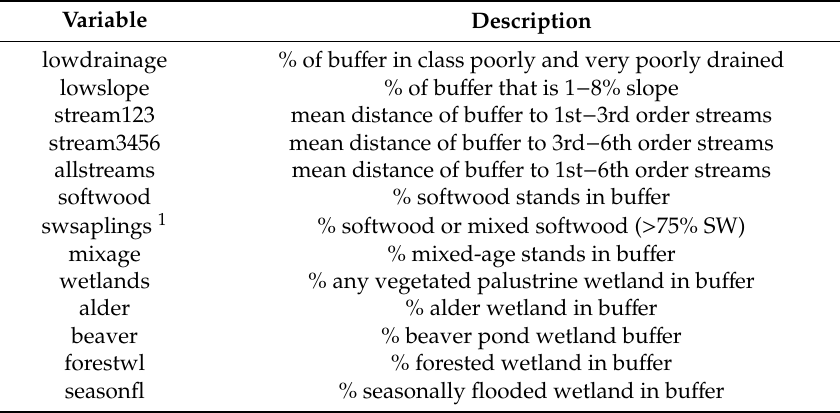
Table 1. Descriptions of habitat variables used for generating logistic regression models for rusty blackbird nests and post-fledging adult and fledgling locations in northern New Hampshire from 2010 − 2012. Bu ff er is a 30 m radius circle around location